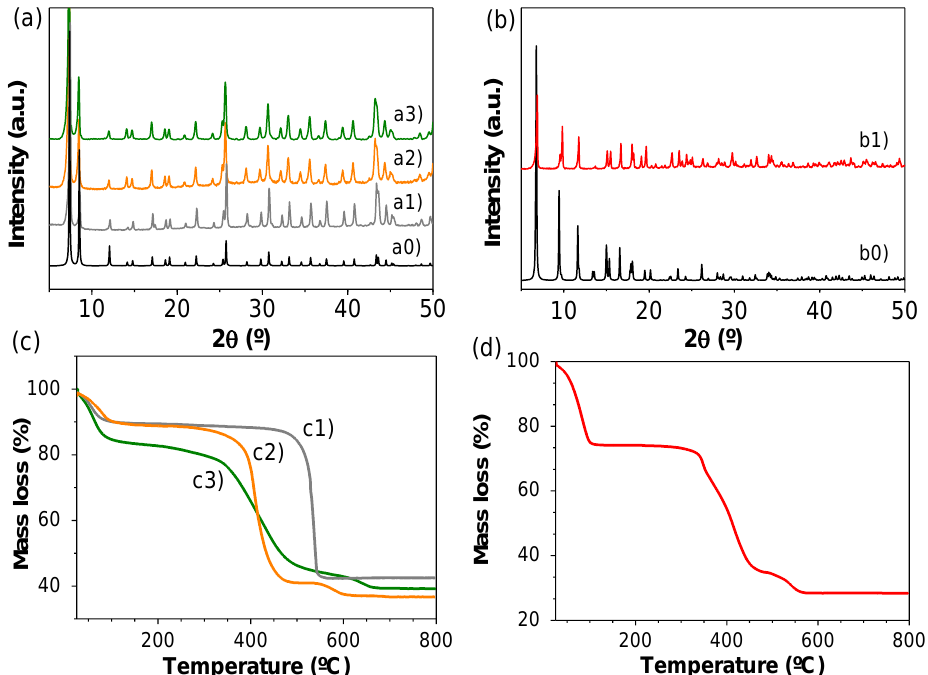
Figure 2. ( a ) XRD patterns of simulated UiO-66(Zr) (a0) and experimental UiO-66(Zr) (a1), UiO-66(Zr)-NO 2 (a2) and UiO-66(Zr)-NH 2 (a3). ( b ) XRD patterns of simulated (b0) and experimental MIL-125(Ti)-NH 2 (b1). ( c ) TGA of UiO-66(Zr) (c1), UiO-66(Zr)-NO 2 (c2), UiO-66(Zr)-NH 2 (c3) and MIL-125(Ti)-NH 2 ( d ).